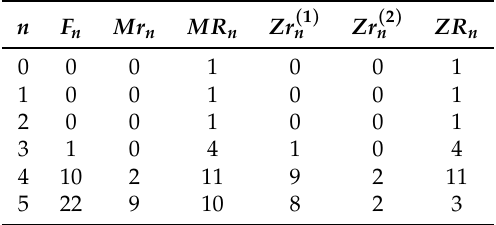
Table 1. Number of individuals and couples of each type in the first six generations for the Y-linked pedigree associated with the inheritance of non-syndromic hearing impairment reported in [20].